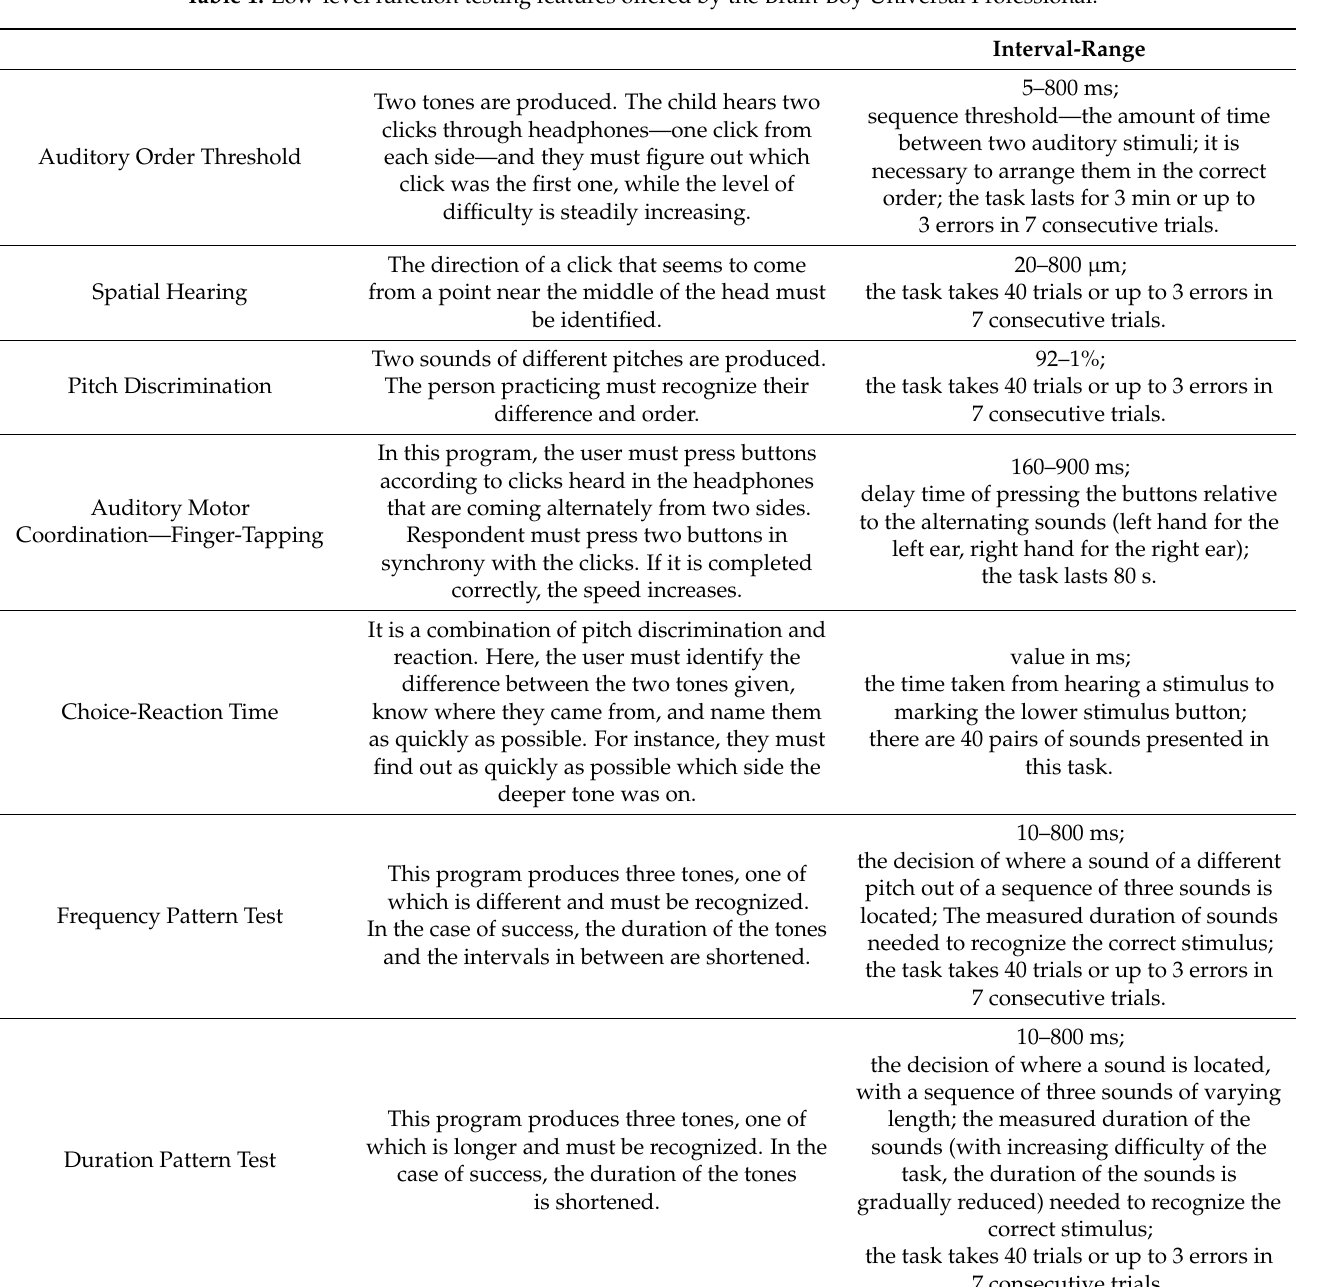
Table 1. Low-level function testing features offered by the Brain-Boy Universal